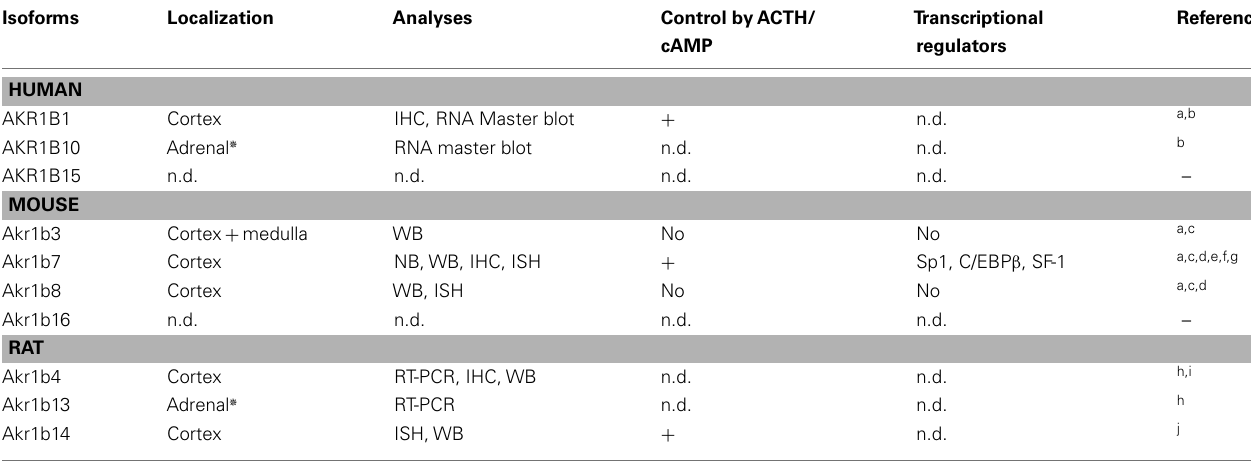
Table 2 | Localization and regulation ofAKR1B expression in adrenal gland. Isoforms